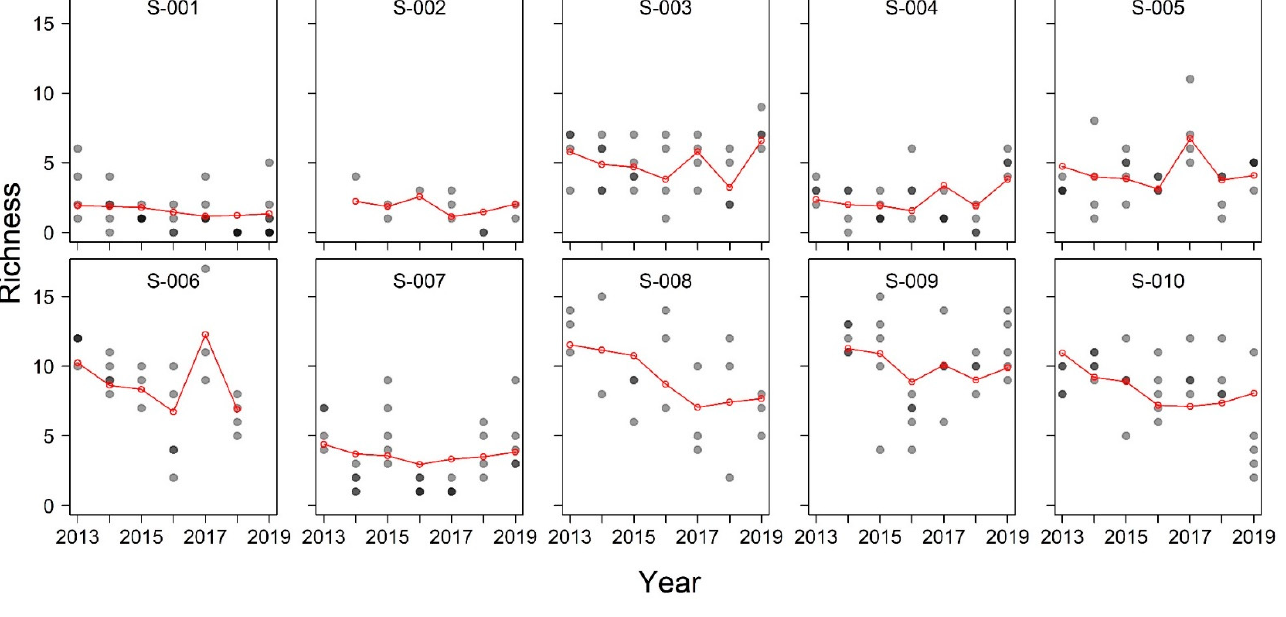
Figure 5. Observed (filled circles) and fitted fish species richness (open circles with lines) for sites over time in the St. Clair and Detroit rivers based on model averaging of 256 candidate generalized linear models. Darkness of circles reflects existence (or not) of overlapping observations. See Figure 1 for locations of sites.